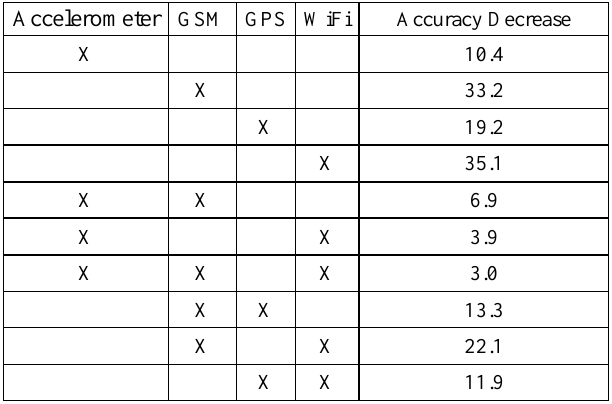
Table 2. Classification accuracy decrease compared to GPS and accelerometer based system